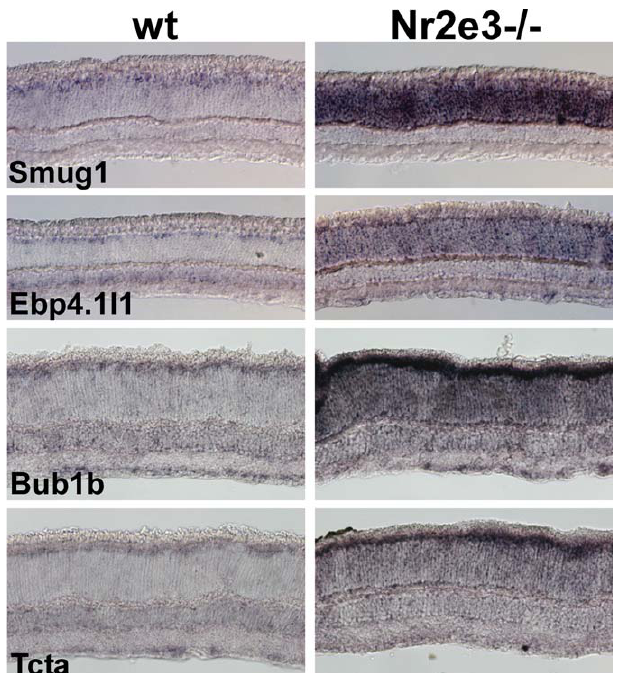
Figure 4. Expression Patterns of Several Novel Cone Genes Up-Regulated in rd7 In the wild-type images (wt), note the scattered, weakly positive cells at the scleral edge of the outer nuclear layer in a cone distribution. All of the genes show marked up-regulation in the rd7 mutant. Bub1b and Tcta show transcript localization predominantly to the inner segment of the photoreceptors. Retinas are oriented such that the scleral edge is up. DOI: 10.1371/journal.pgen.0010011.g004